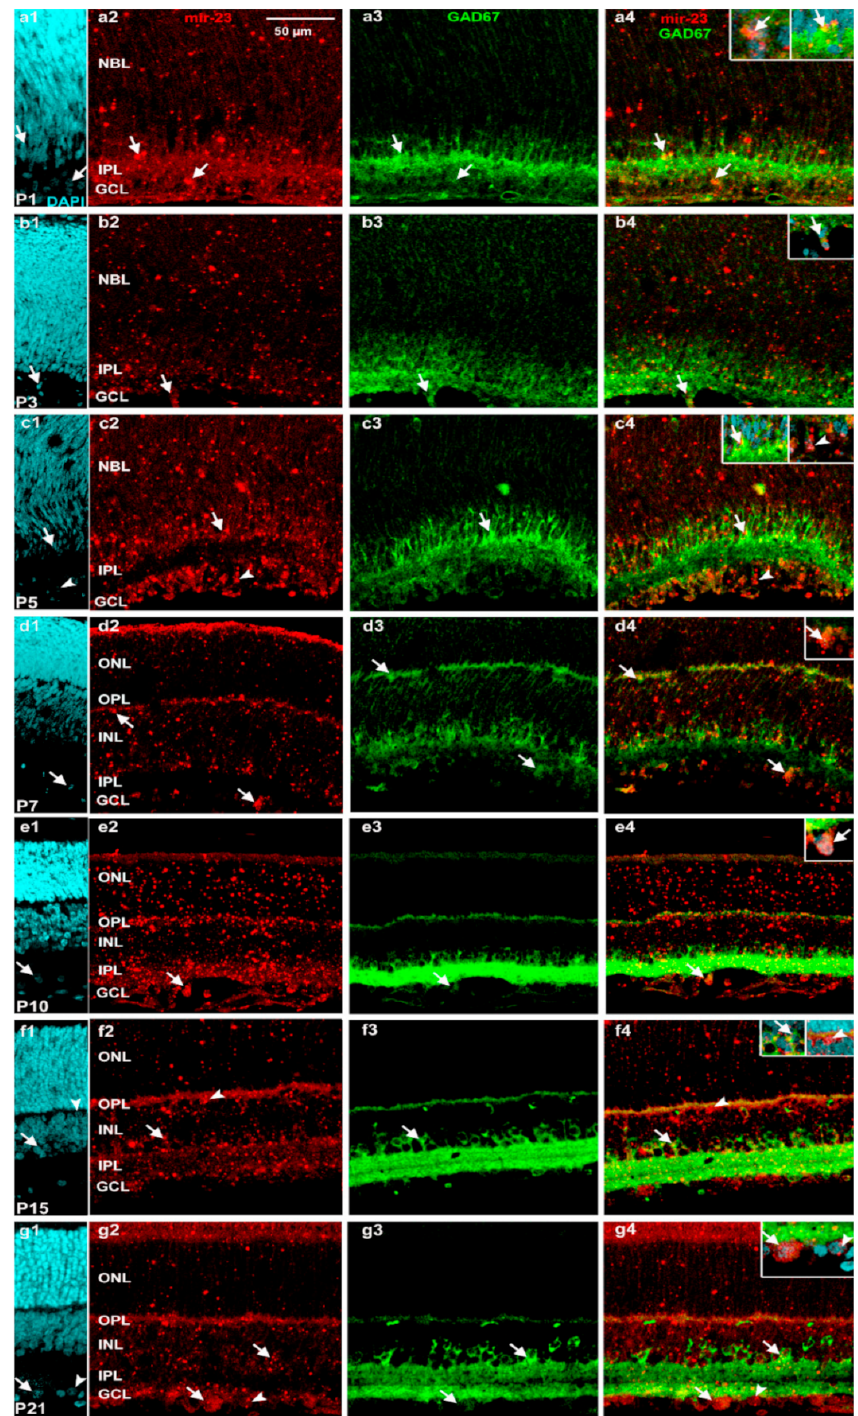
Figure 5. Characterization of miR-23 (red: TSA Cy3) expressing cells (in situ hybridization) and GAD67 (green: Alexa Fluor-488) by immunolabeling in postnatal developing retina sections of indicated ages (( a1 – a4 ) P1; ( b1 – b4 ) P3; ( c1 – c4 ) P5; ( d1 – d4 ) P7; ( e1 – e4 ) P10; ( f1 – f4 ) P15; ( g1 – g4 ) P21). The first column demonstrates the DAPI staining, the second column miR-23 and third column represent GAD67 staining. The fourth column demonstrates the merged images of ISH–IHC staining. Arrows indicate colocalization, and non-colocalized cells were demonstrated by arrowheads. Scale layer, INL—inner nuclear layer, OPL—outer plexiform layer, ONL—outer nuclear